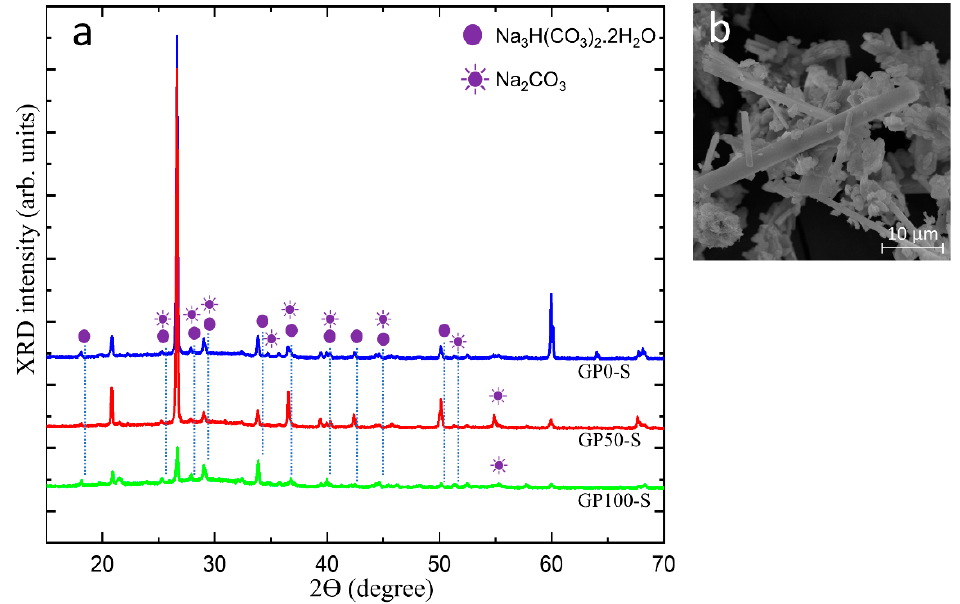
Figure 11. Diffractogram of the efflorescence in group S mortars ( a ) and micrograph of the trona crystals ( b ).